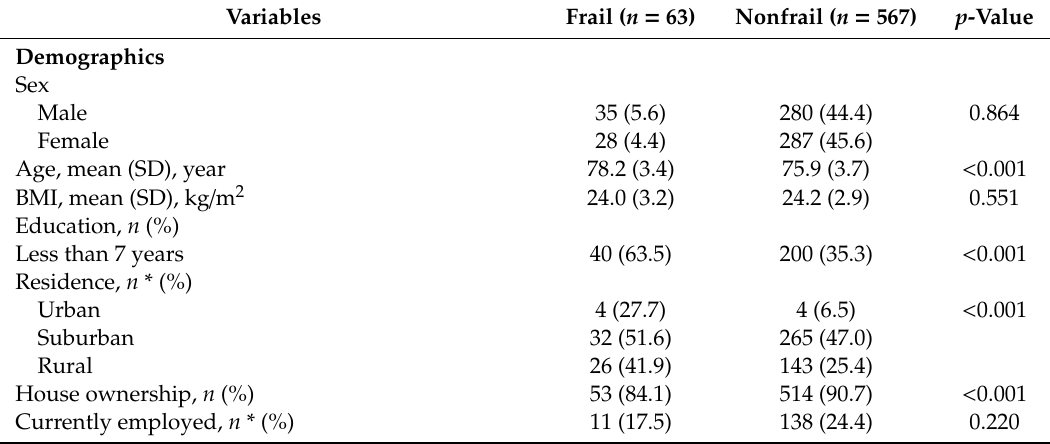
Table A1. Demographic and health characteristics of frail and nonfrail